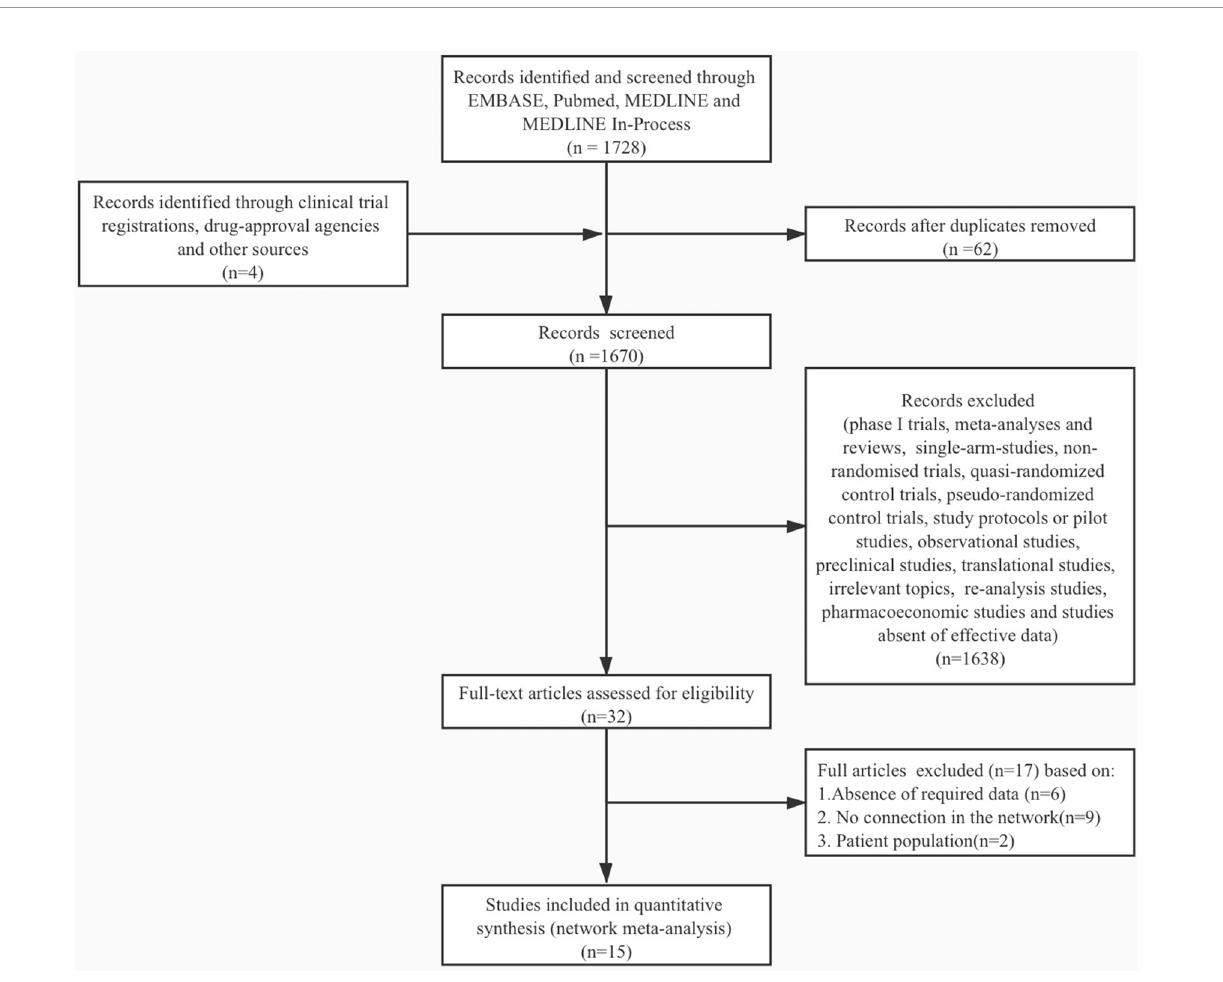
FIGURE 1 | Study selection fl owchart. A total of 1667 citations were identi fi ed by the primary research, and 15 eligible articles remained in the fi nal network meta- analysis. The fl owchart was made under the PRISMA guideline